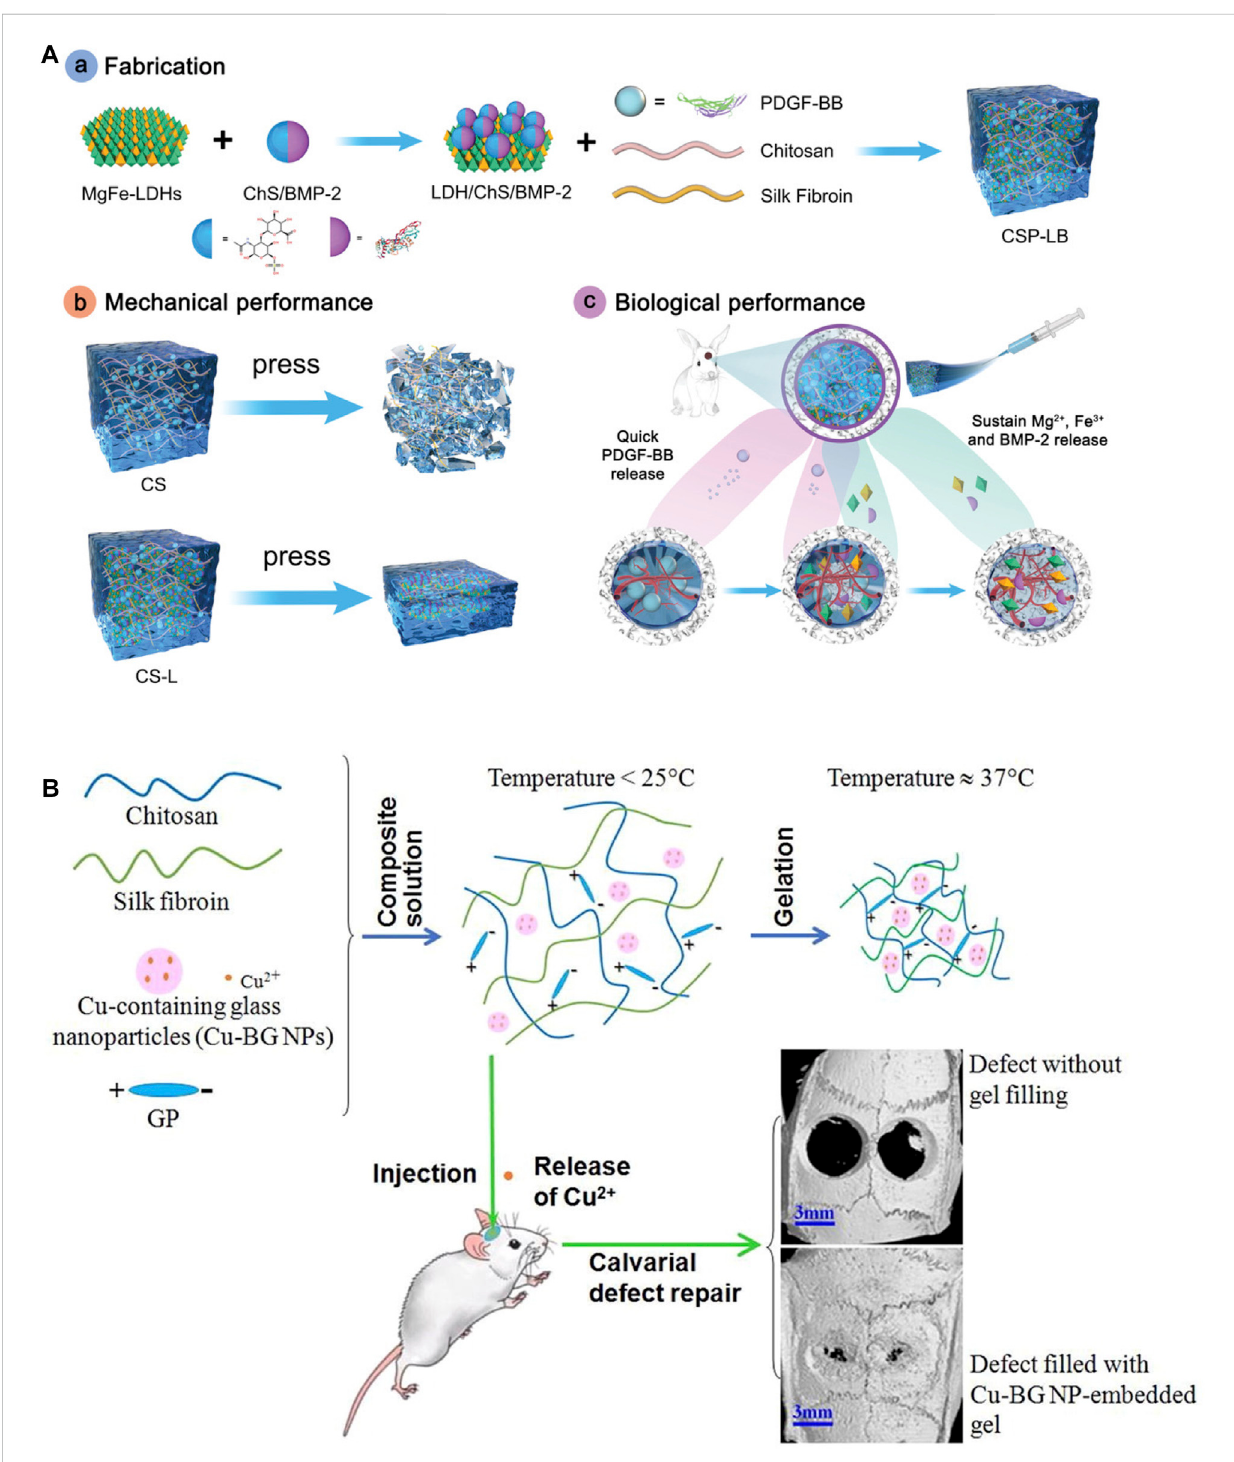
FIGURE 4 Injectable silk protein-based hydrogels. (A) Angiogenic PDGF-BB loaded chitosan/silk fi broin (CS) hydrogel incorporated with osteogenic BMP-2- functionalized MgFe-LDH. (B) Injectable chitosan (CH)/silk fi broin (SF)/glycerophosphate (GP) composite hydrogels triggered by temperature. Adapted with permission from ref (Wu et al., 2019; Lv et al., 2022). Copyright 2019 Elsevier, 2022